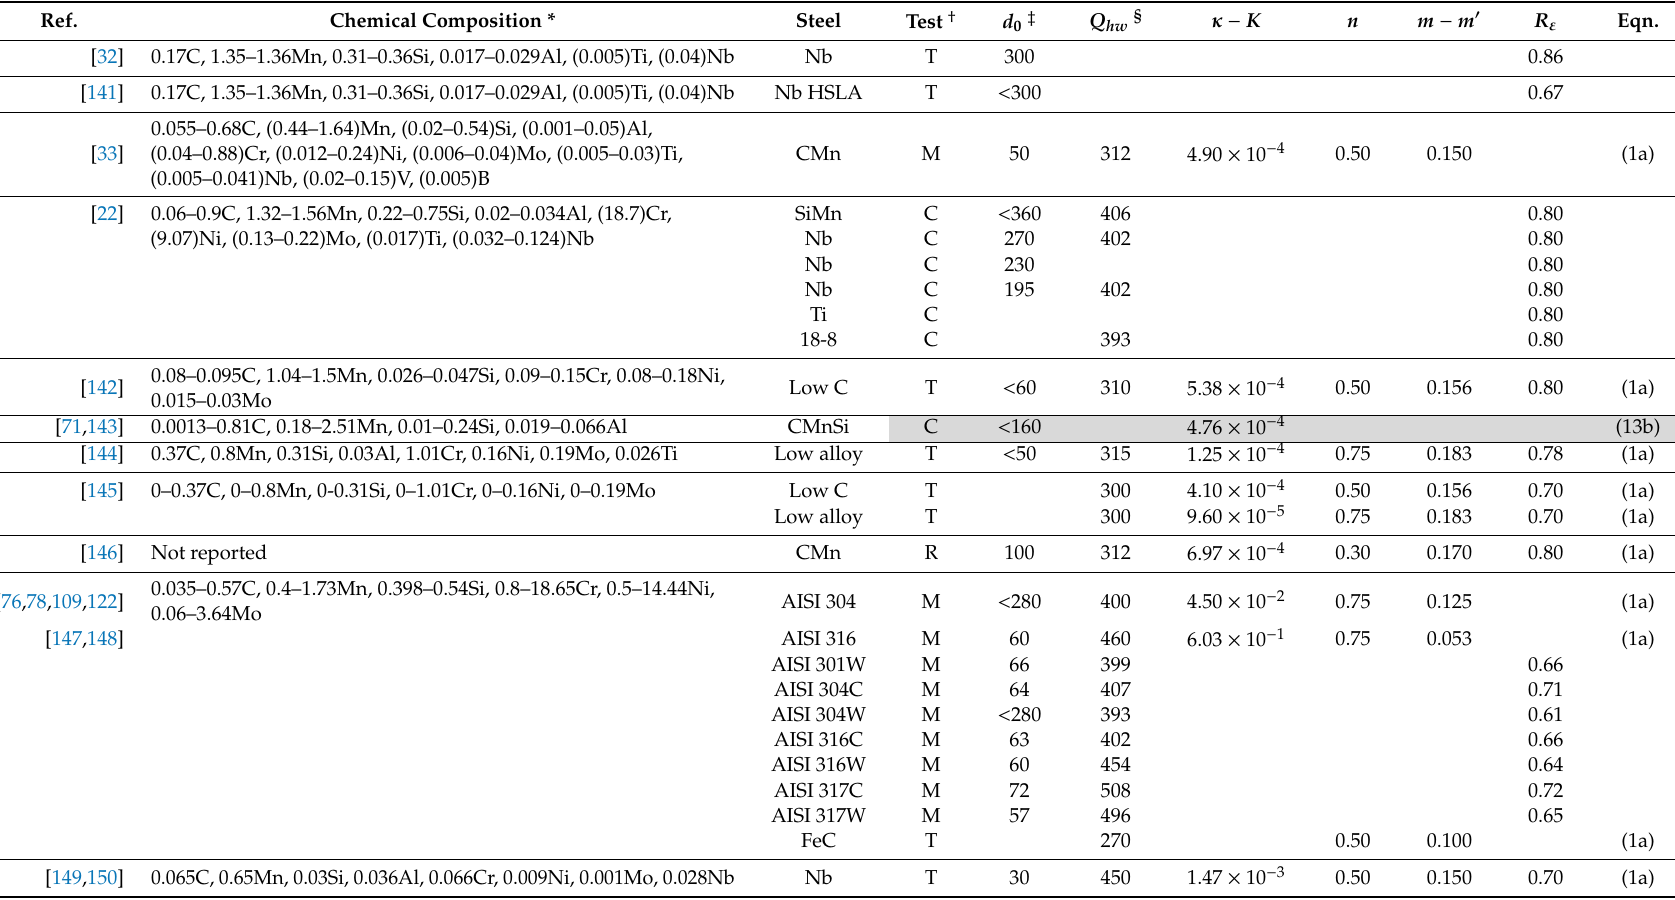
Table A1. Literature collection of the reported values for the parameters for cited equations. See details in Section